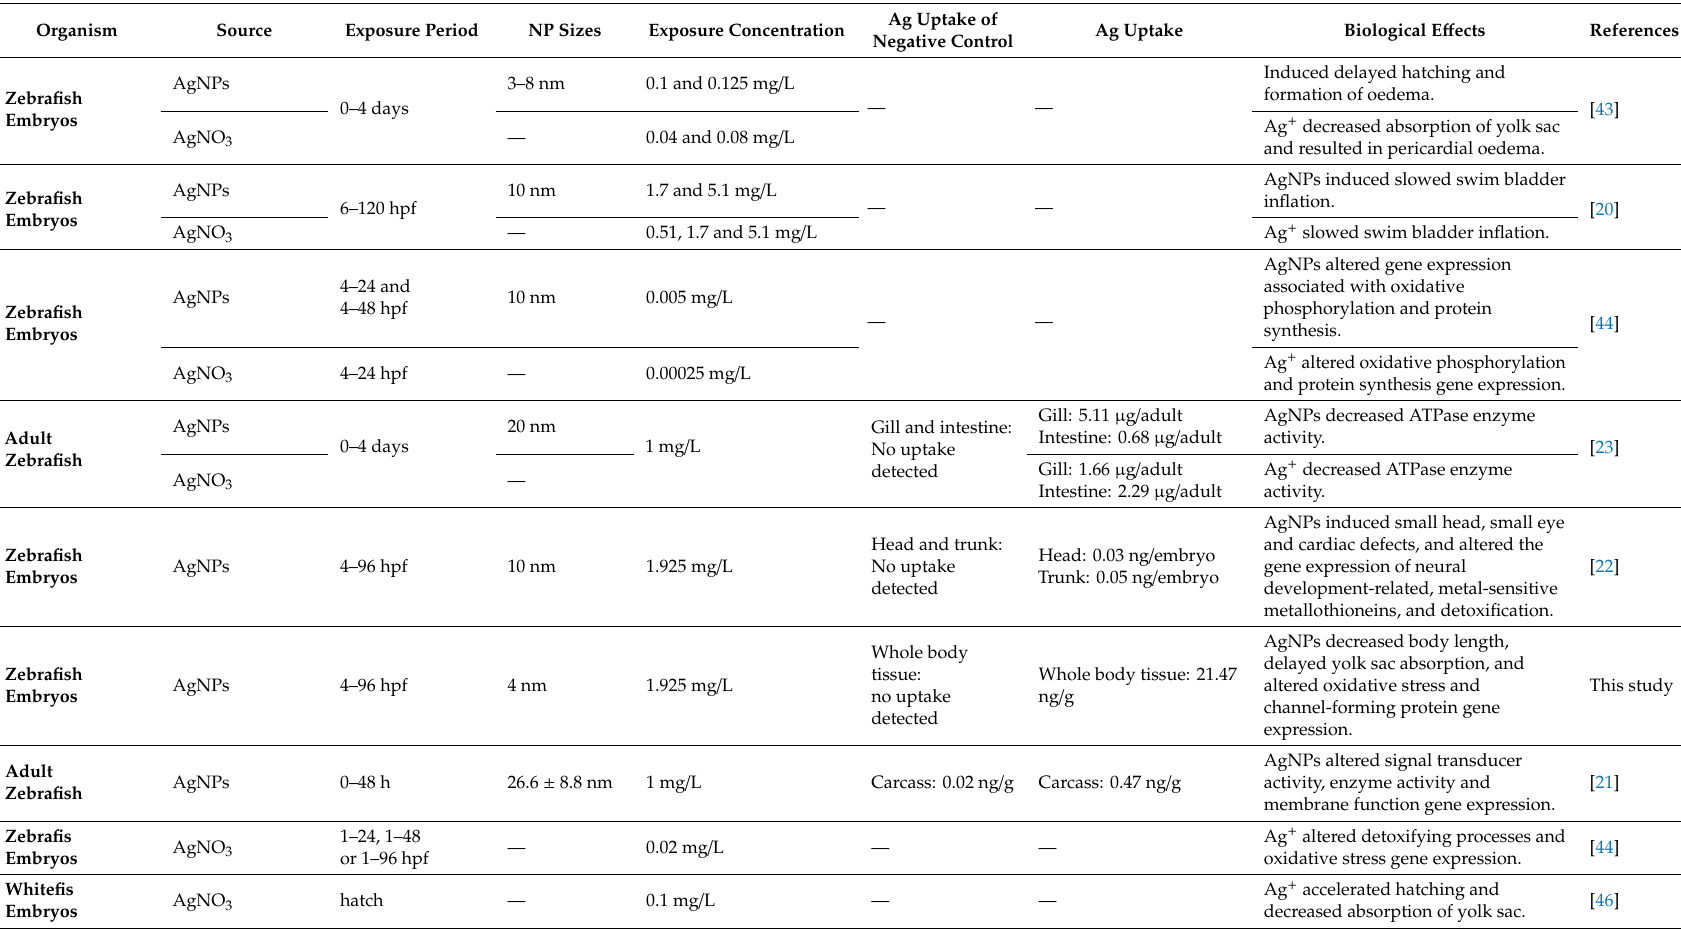
Table 1. A summary of the observed toxicity impacts of AgNPs and silver ions reported in the